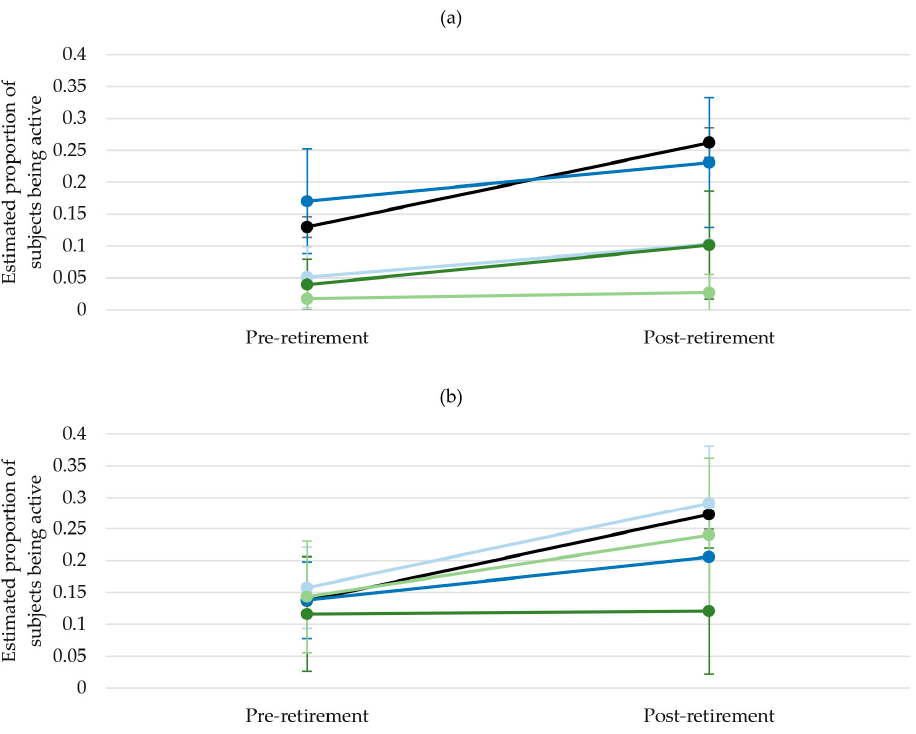
Figure 3. Figure 3. Cont .